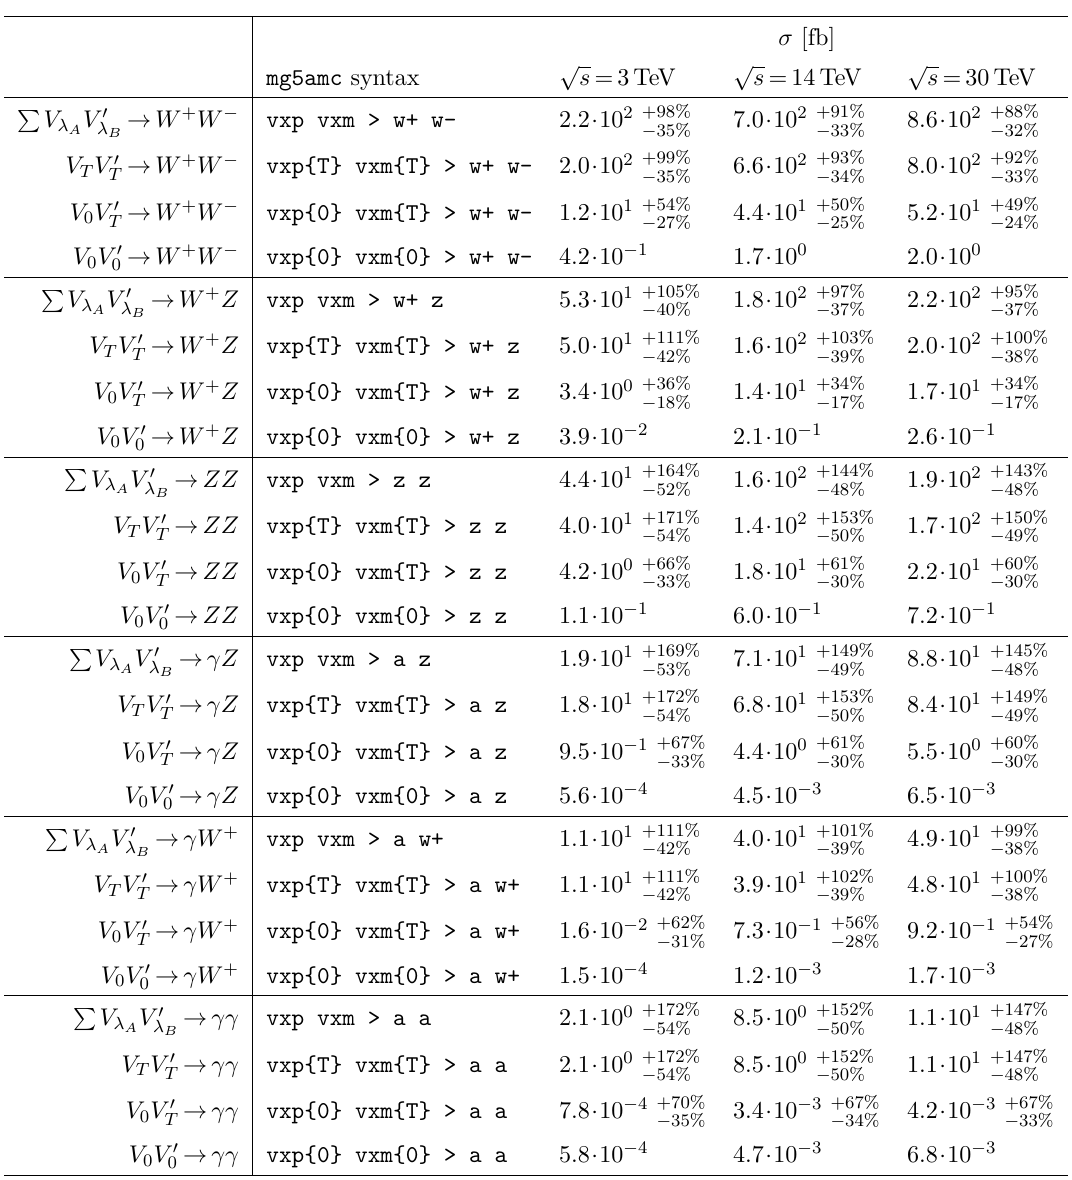
Table 6 . Same as table 4 but for V V